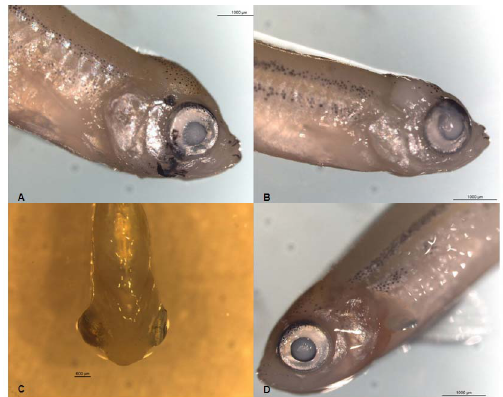
Figure 4. Morphological changes in D.rerio during the 48 hours of exposure to piplartine. A ) Leakage of the ocular pigment caused by 1.8 ppm piplartine, B ) tissue alterations on the head and mouth caused by 1.6 m g/ml piplartine, C ) exophthalmia and hemorrhage caused by 1.4 m g/ml piplartine and D) control